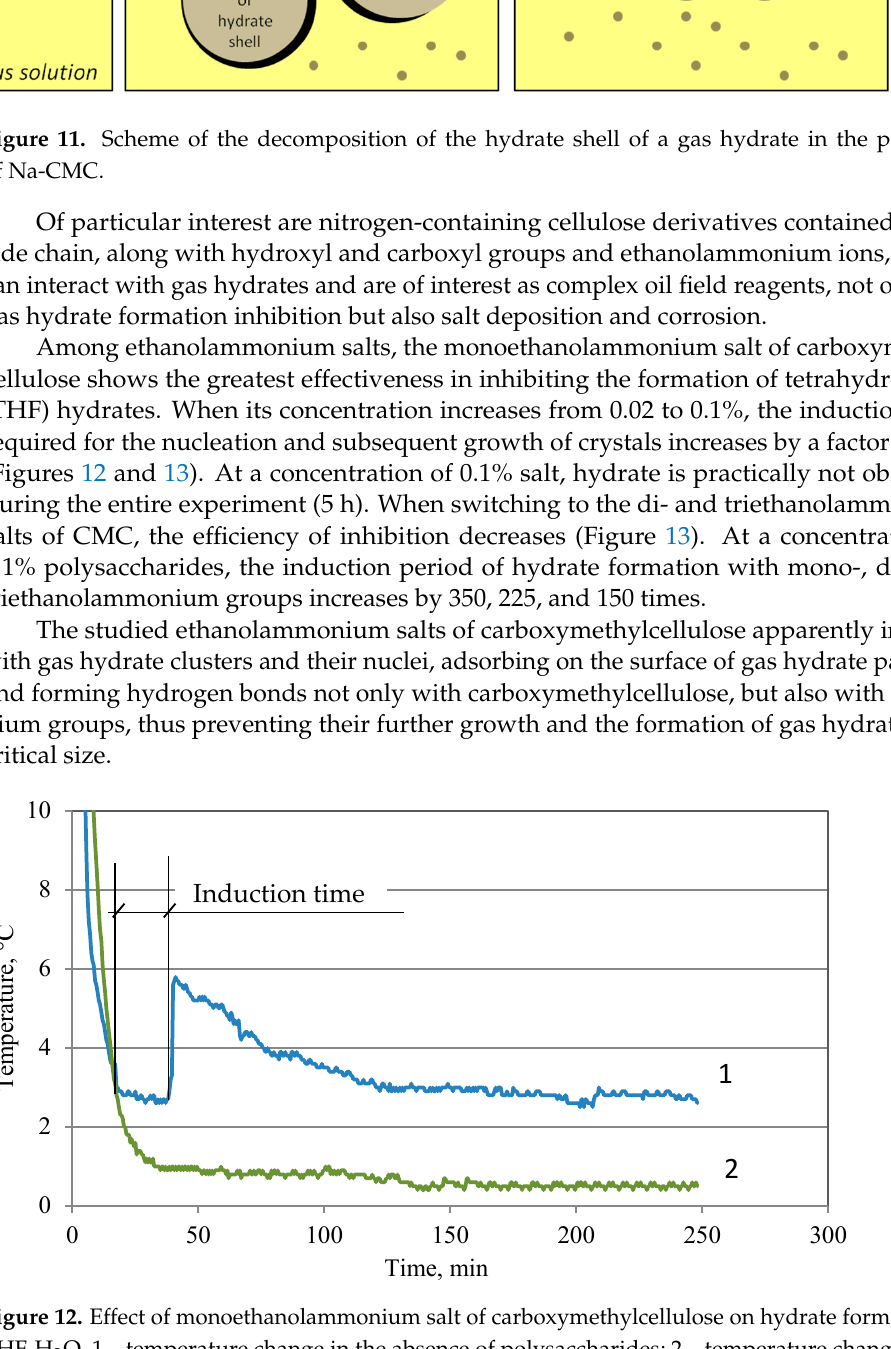
Figure 13. Dependence of induction time of hydrate formation on methanol concentration (1) and mono- (2), di- (3), and triethanolammonium salts of carboxymethylcellulose (4).